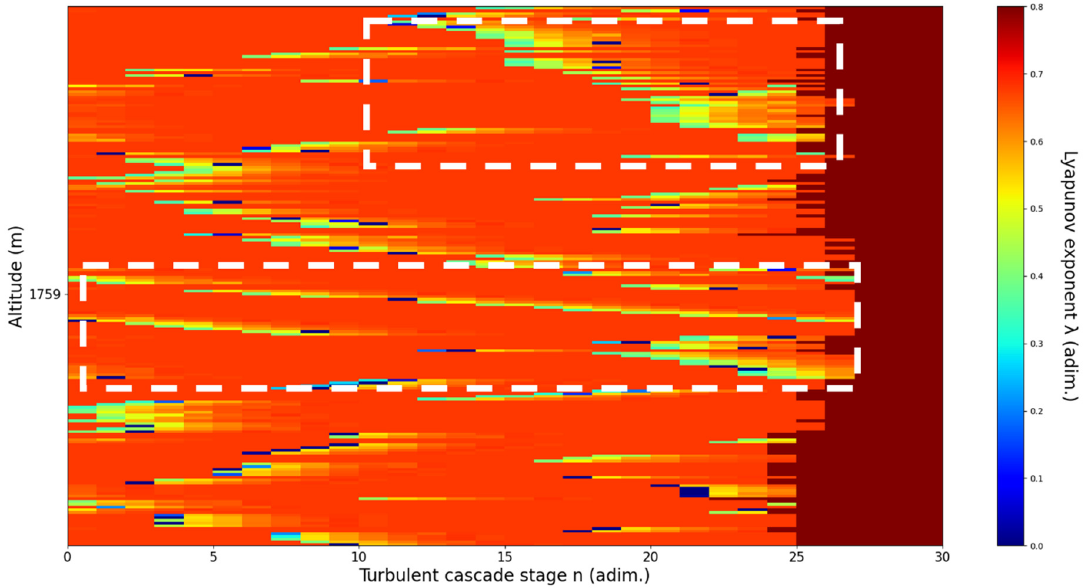
Figure 23. Lyapunov exponent per turbulent cascade stage colormap altitude plot, Bucharest, Romania, 13 June 2019,